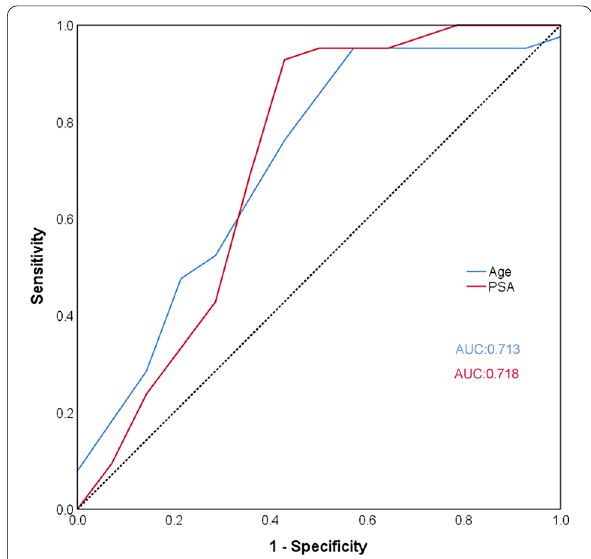
Fig. 5 ROC analysis of age and serum PSA of 68 Ga-PSMA PET/CT for the detection of low- and intermediate-risk PCa